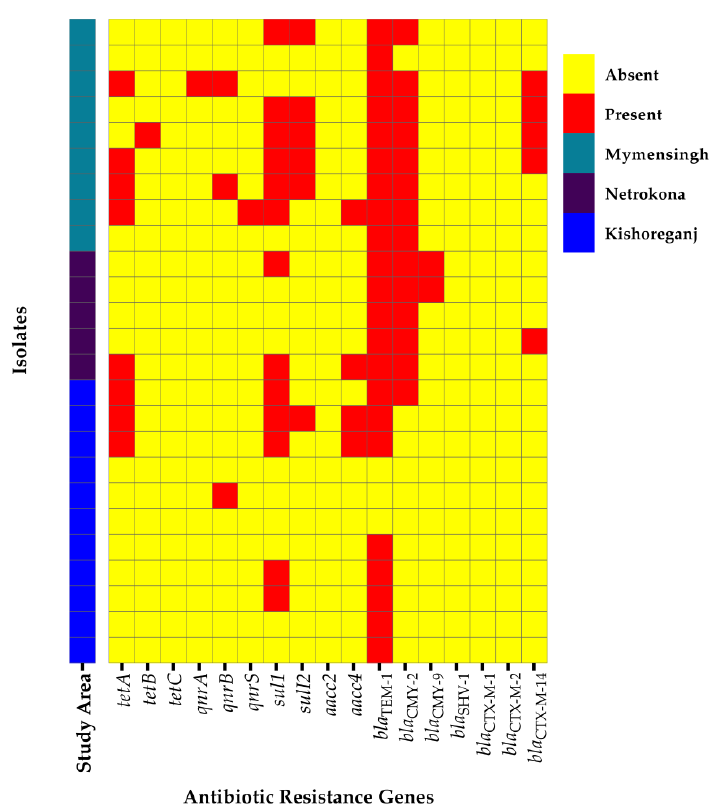
Figure 2. Heatmap showing the distribution of various antibiotic resistance genes of C. freundii isolated from cloacal swabs of ducks in Bangladesh. In the bivariate analysis, a high positive significant correlation was observed between the presence of antibiotic resistance genes aac4 and tetA (Pearson correlation coefficient, ρ = 0.636; p = 0.001), qnrA and qnrB ( ρ = 0.553; p = 0.004), and sul1 and sul2 ( ρ = 0.540; p = 0.005) (Supplementary Table S2). Moreover, moderate-to-low positive significant correla- tions were also observed between the presence of resistance genes tetA and sul1 ( ρ = 0.487; p = 0.013), qnrS and aacc4 ( ρ = 0.468; p = 0.018), bla CMY-2 and bla CTX-M-14 ( ρ = 0.443; p = 0.026), bla CTX-M-14 and sul2 ( ρ = 0.421; p = 0.036), aac4 and sul1 ( ρ = 0.419; p = 0.037), bla TEM-1 and bla CMY-2 ( ρ = 0.417; p = 0.038), tetB and bla CTX-M-14 ( ρ = 0.408; p = 0.043), and qnrA and bla CTX-M- 14 ( ρ = 0.408; p = 0.043) (Supplementary Table S2).